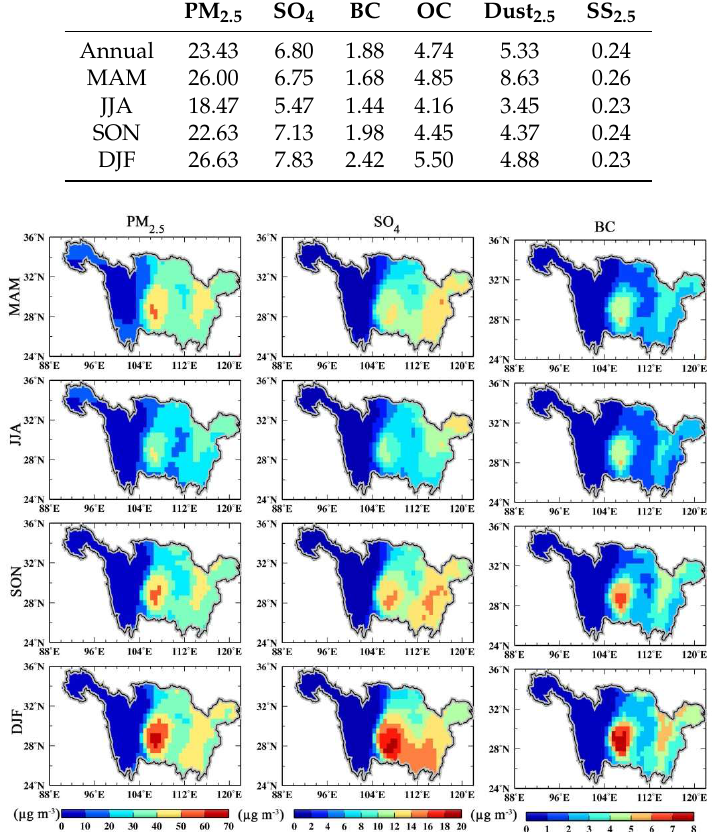
Figure 7. Seasonal variations of each MERRA-2 PM 2.5 component: ( left ) the PM 2.5 , ( middle ) SO 4 and ( right ) BC over the YRB during 1980–2017.